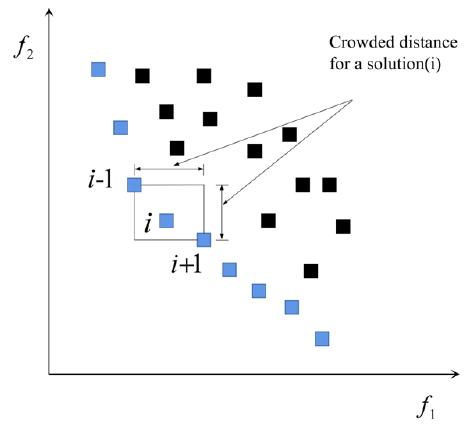
Figure 7. Crowding distance.